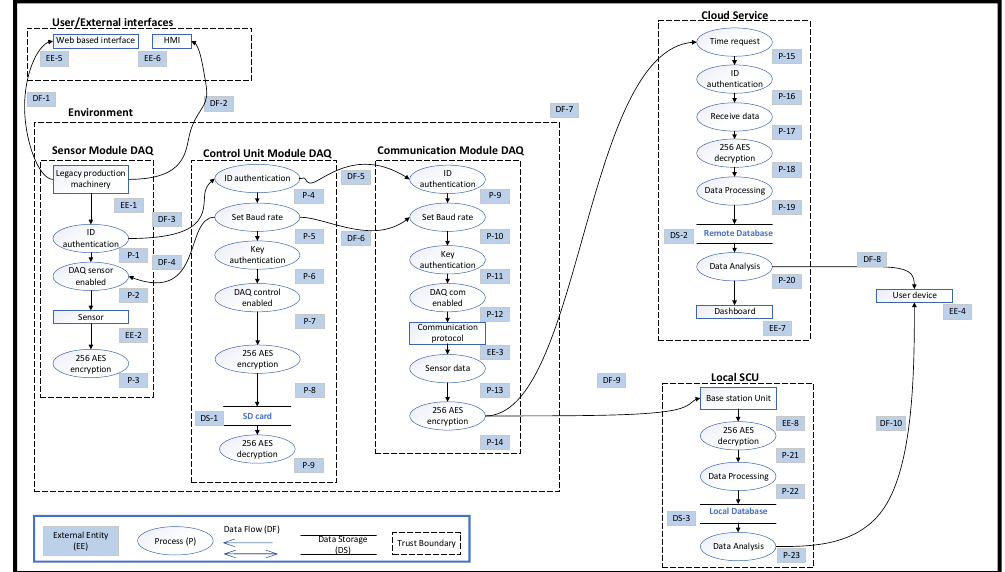
Figure 12. Data flow diagram of the connected legacy production machinery.